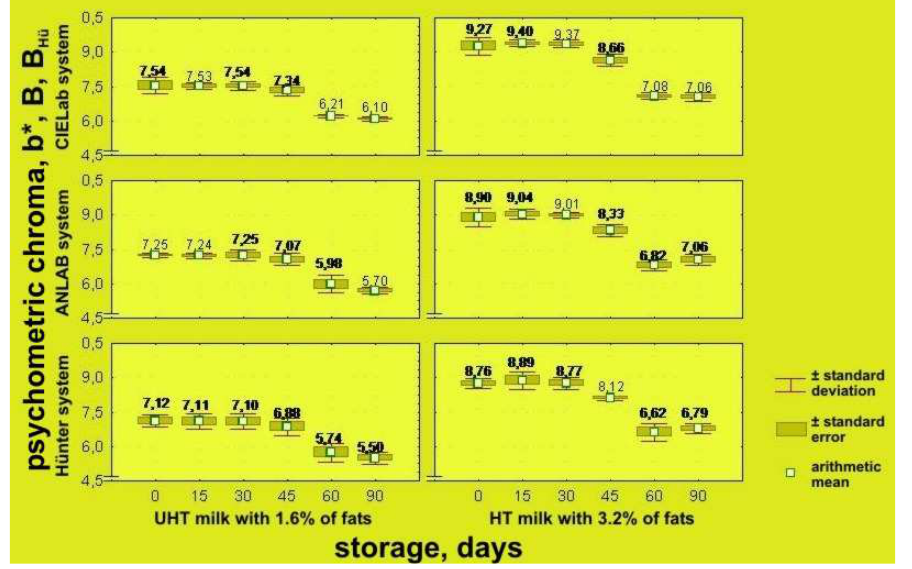
Figure 7. Effects of storage time on changes of psychometric chroma of UHT milk samples with 1.6% and 3.2% milk fat in CIELab, ANLAB and Hünter’s